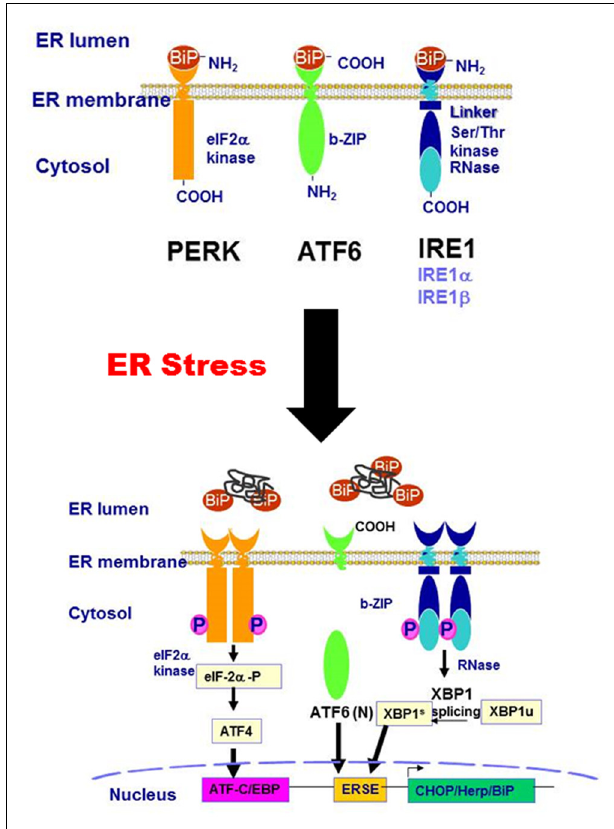
FIGURE 1 | Schematic diagram of the ER stress-activated signaling